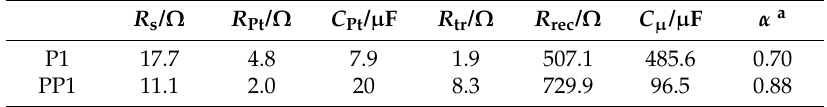
Table 2. EIS data obtained from measurements at a light intensity of 22 mW cm − 2 of p-type DSCs containing FTO/NiO working electrodes, P1 or PP1 dyes, and an electrolyte comprising I − /I 3 − in MeCN.